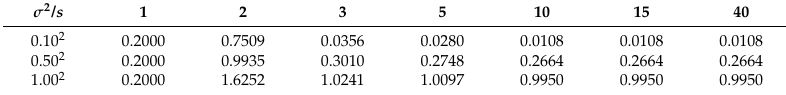
Figure 4. The true outputs and predictions with noise variance σ 2 = 0.10 2 . Table 2. The estimates of noise variance versus s under the proposed VB algorithm.